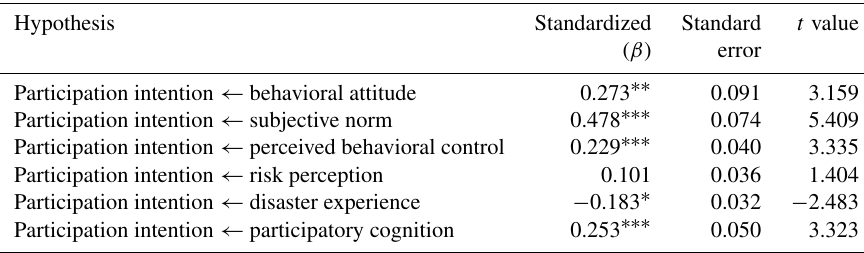
Table 6. Standardized path coefficient